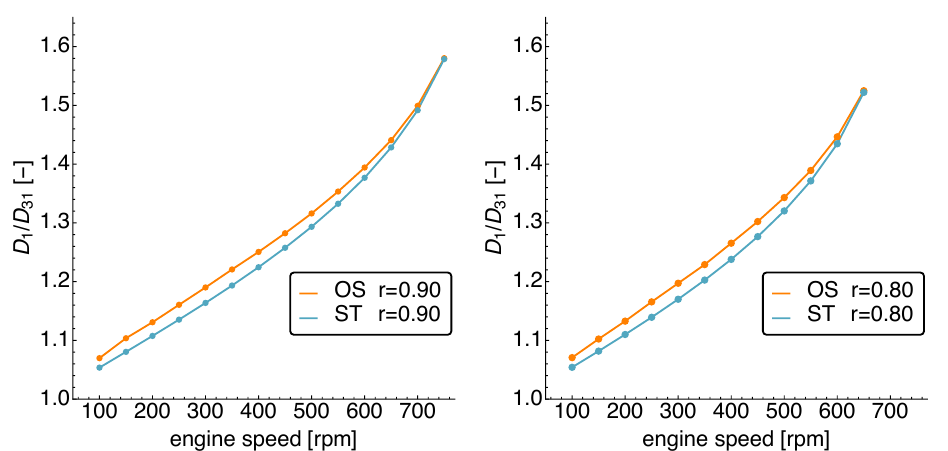
D Figure 8. The displacement ratio D 1 / 31 necessary to gain sufficient mechanical power to overcome the friction vs. engine speed for OS and ST motion at different values of the regeneration coefficient ( left / right ). With increasing speed, the displacement ratio increases more than linear. For high- regeneration as well as high-operation speed a slightly larger displacement ratio is necessary. Note that the optimized motion (OS) necessitates a larger displacement ratio as compared with the standard motion (ST).